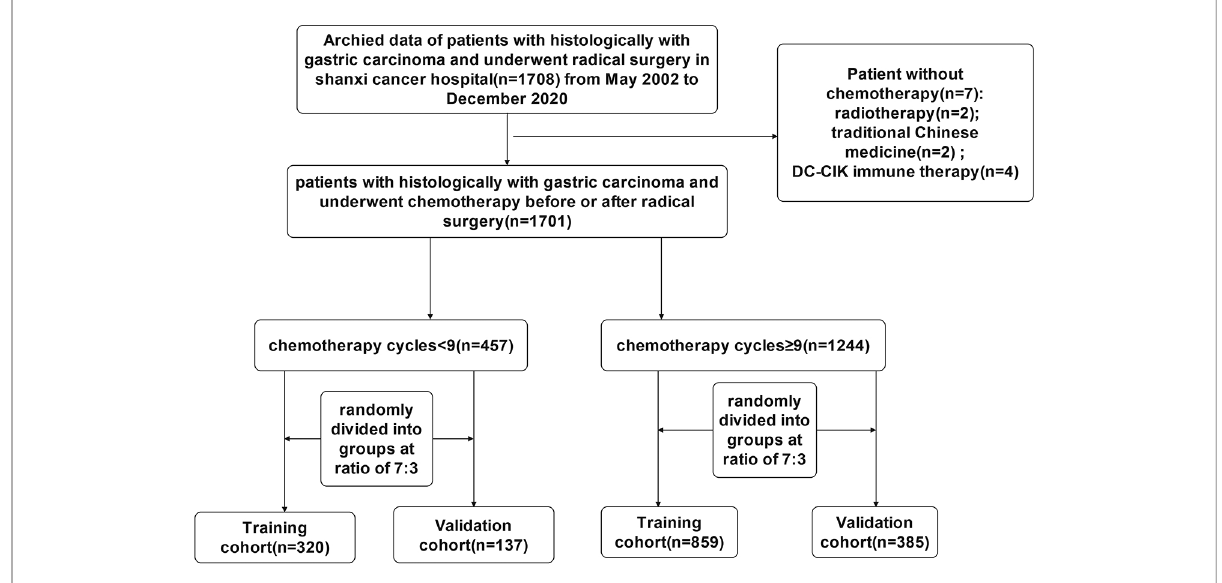
FIGURE 1 The fl owchart of study population enrolment in the training and validation cohort of gastric